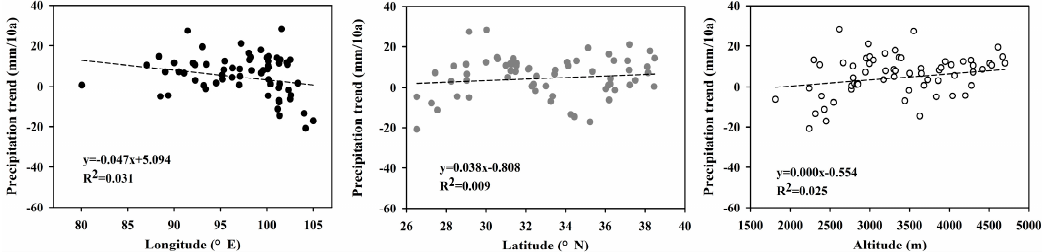
Figure 7. The relationship between the precipitation trend and longitude, latitude and altitude.